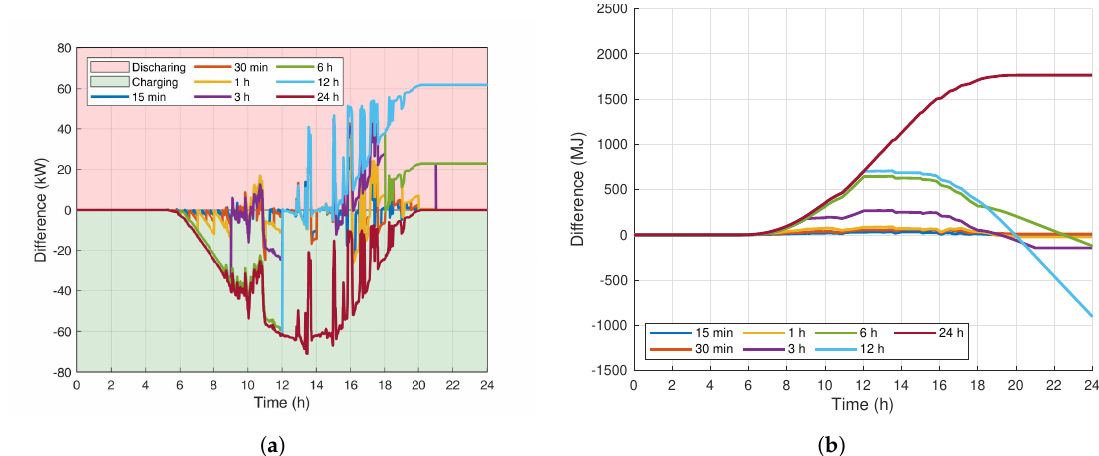
Figure A1. The resulting PV power and energy forecast differences that arise from the use of temperature and solar irradiance forecast when compared to the known truth atmospheric time series of the renewable asset assuming MPPT for the partly cloudy sky conditions. ( a ) The partly cloudy sky PV power forecast differences. ( b ) The partly cloudy sky PV energy forecast differences.